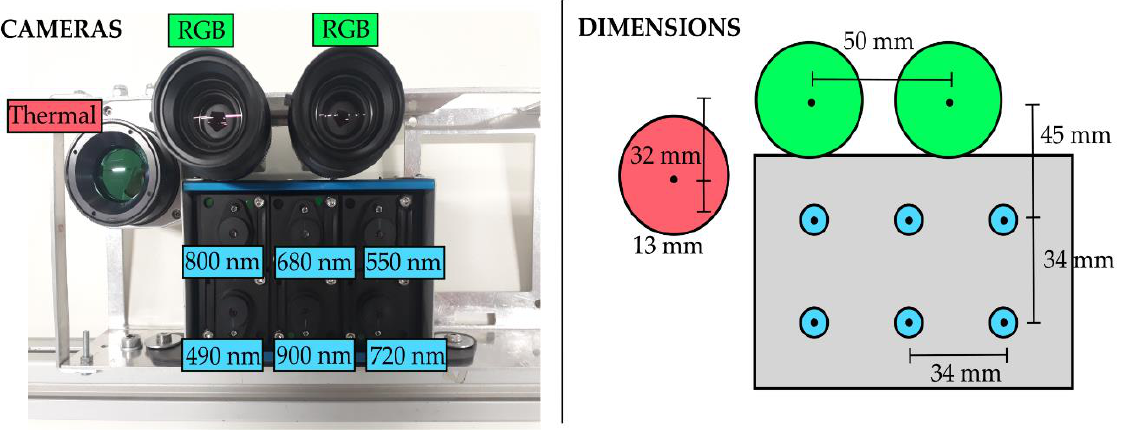
Figure 2. Disposition of the cameras.